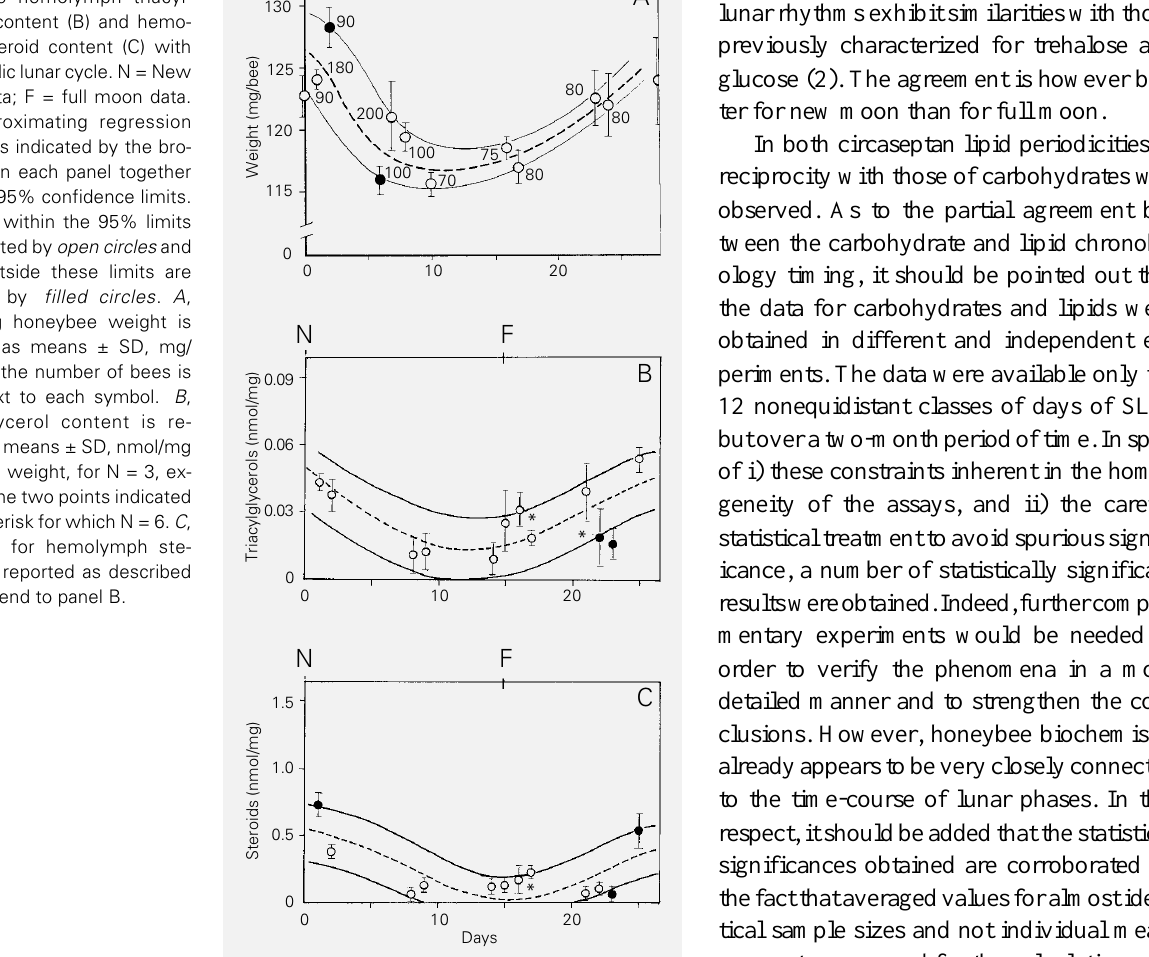
Figure 1 - Correlation of emerg- ing worker bee weight (A) and honeybee hemolymph triacyl- glycerol content (B) and hemo- lymph steroid content (C) with the synodic lunar cycle. N = New moon data; F = full moon data. The approximating regression function is indicated by the bro- ken line in each panel together with the 95% confidence limits. The data within the 95% limits are indicated by open circles and those outside these limits are indicated by filled circles . A , Emerging honeybee weight is reported as means – SD, mg/ bee, and the number of bees is given next to each symbol. B , Triacylglycerol content is re- ported as means – SD, nmol/mg bee fresh weight, for N = 3, ex- cept for the two points indicated by an asterisk for which N = 6. C , The data for hemolymph ste- roids are reported as described in the legend to panel